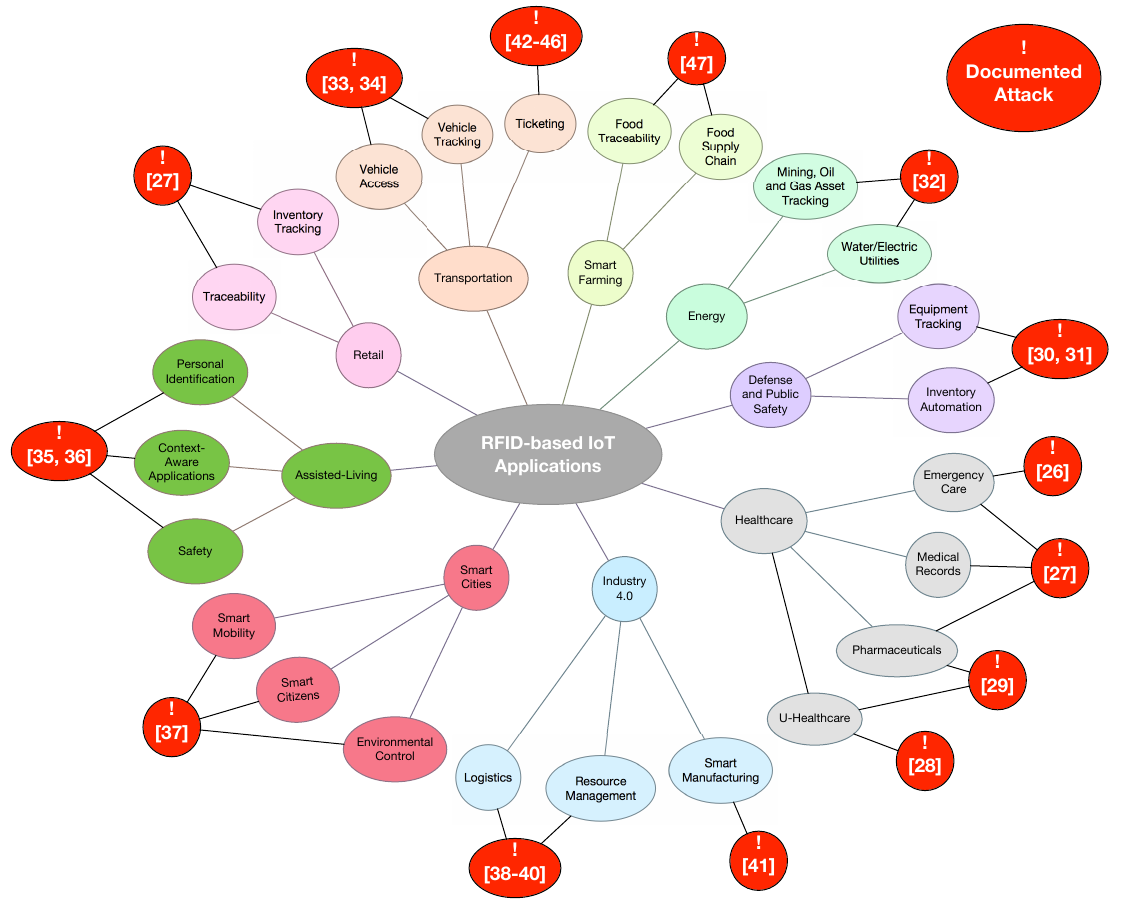
Figure 1. Main RFID-based IoT